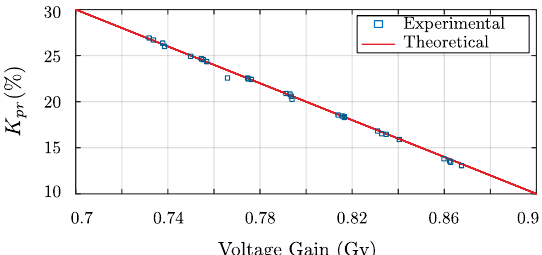
Figure 12. Experimental result of the partial power ratio for the step-down Full-bridge based PPC under the variation of the voltage